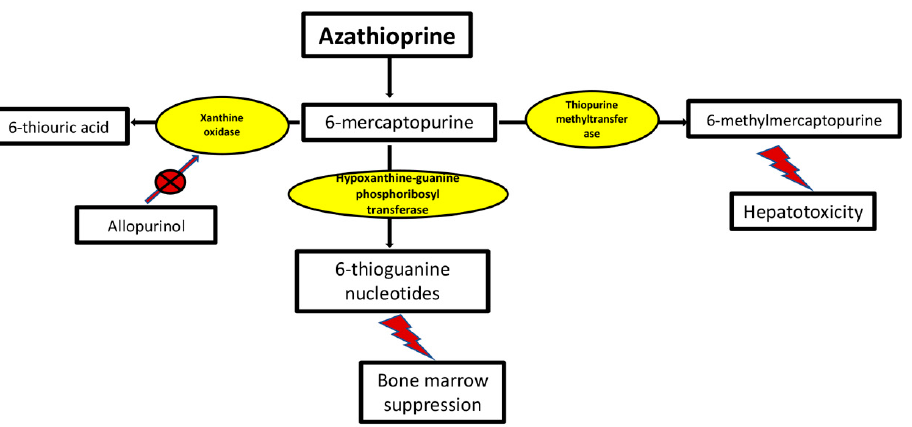
Figure 1. Azathioprine metabolism. Deficiency of thiopurine methyltransferase results in